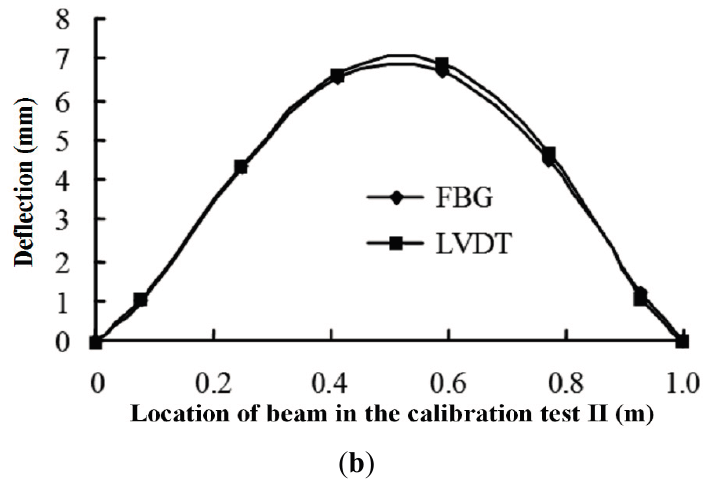
Figure 5. Comparative curves of the deflection values obtained by FBG and LVDT sensors. ( a ) The calibration test of tension; ( b ) The calibration test of